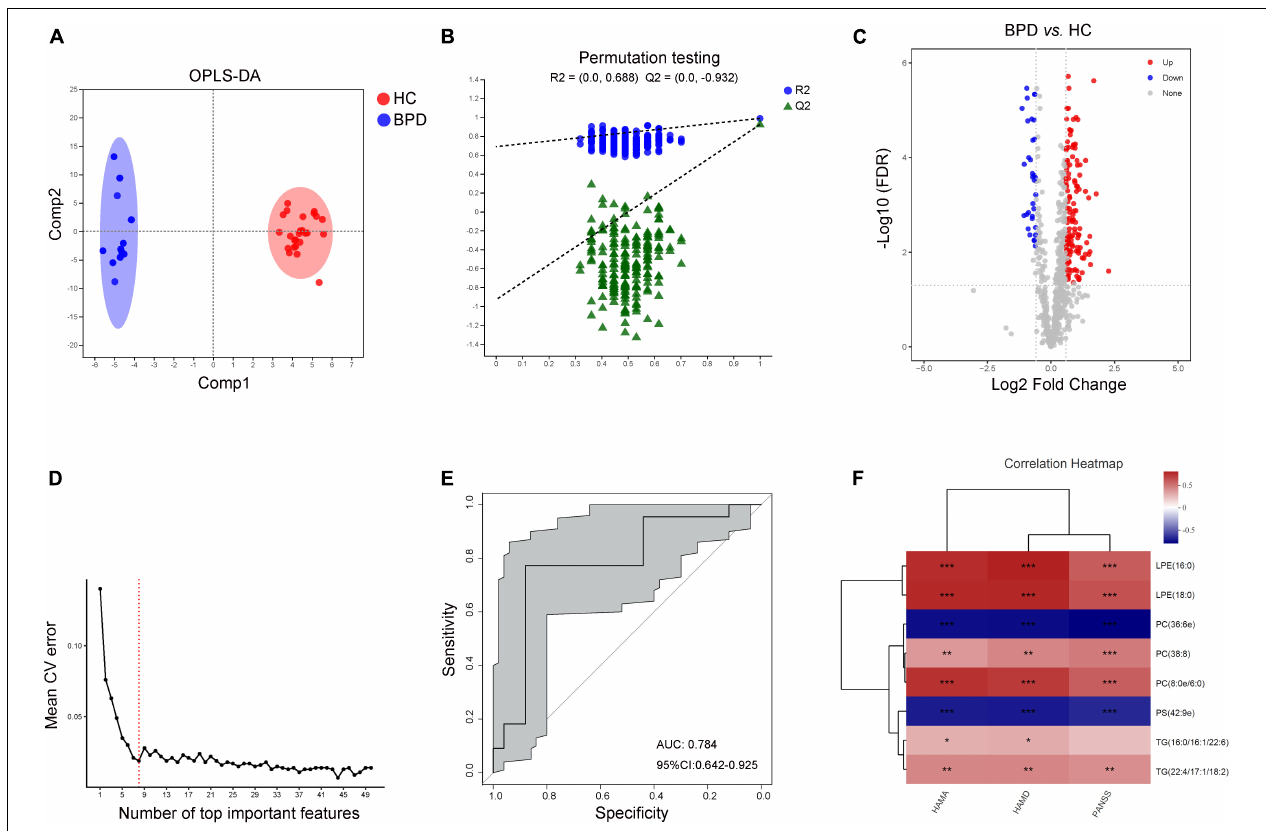
FIGURE 4 | Characteristic lipid species in BPD. (A) Scatter plot of OPLS-DA model and (B) validation model of permutation test, (C) volcano map reveals the increased (red dots) and decreased (blue dots) lipid species between the BPD and HC, (D) random forest model and 10-fold cross-validation showed that the lipids with the top 8 importance had the lowest model error rate, (E) ROC analysis for the combinational lipids, (F) correlation between clinical parameters and levels of 8 lipid species. * P < 0.05; ** P < 0.01, *** P <